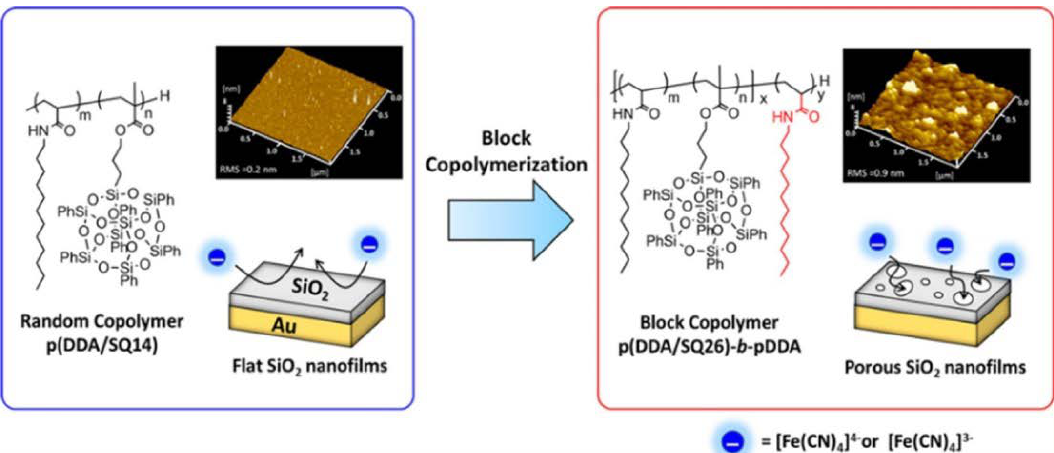
Figure 17. Schematic illustration of the preparation of the hybrid block copolymer consisting of N - dodecyl acrylamide (DDA) and silsesquioxane (SQ) comonomers (p(DDA/SQ26)- b -pDDA) and the assembled Langmuir–Blodgett (LB) nanofilms as well as the porous nanofilms. Reprinted with permission from [77]. Copyright (2018) American Chemical Society.